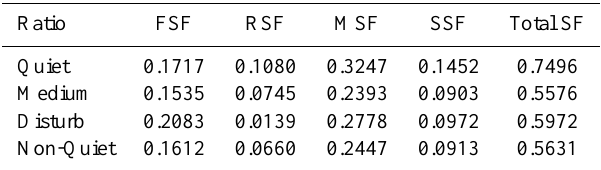
Table 1. Ratio of occurrence number of SF to observed days during the Quiet(Kp < 3 − ), Medium(3 − ≤ Kp < 6 − ), Disturb(6 − ≤ Kp), and Non-Quiet(3 − ≤ Kp)